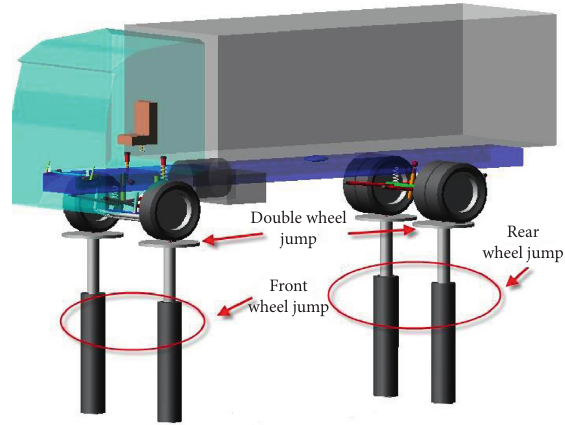
Figure 4: The vehicle multibody model under the incentive pedestal.